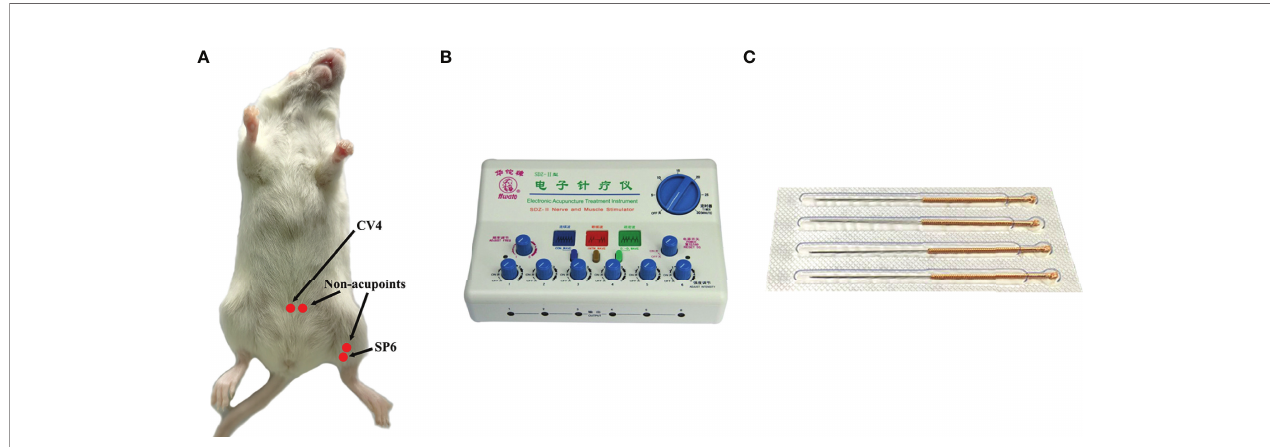
FIGURE 1 | The location of acupoints (CV4 and SP6) and corresponding non-acupoints on mice (A) ; the EA instrument (B) ; stainless steel acupuncture needle of 0.25 mm × 13 mm (C)